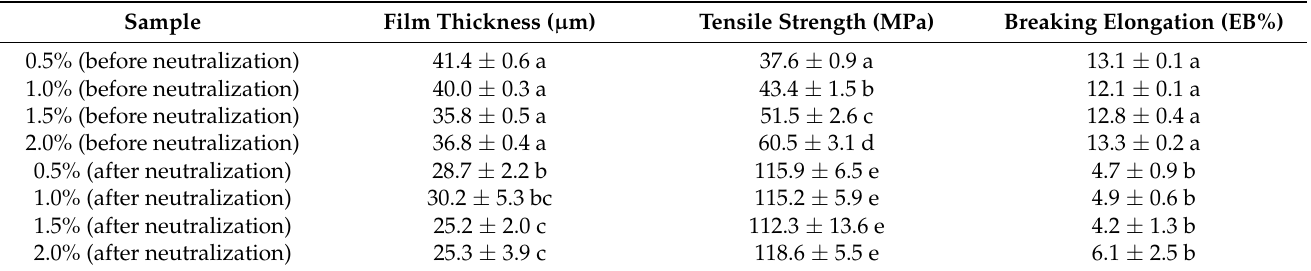
Table 1. Effects of chitosan concentration on tensile strength and elongation at break of chitosan films before and after